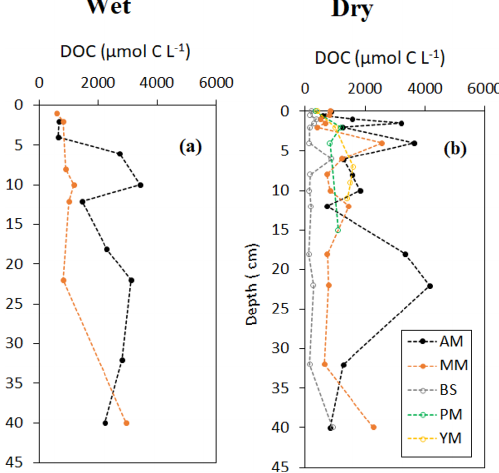
Figure 5. Vertical profiles of porewater DOC during the wet and dry